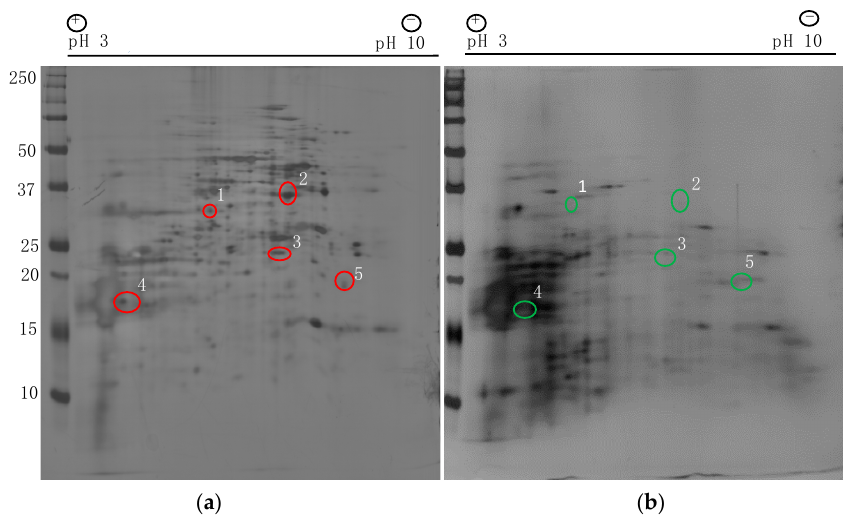
Figure 1. Cell surface proteins extracted from Candida auris biofilm and planktonic cells and resolved by 2-Dimensional Gel Electrophoresis (2-DE). Silver stained gel images of proteins from biofilm ( a ) and planktonic cells ( b ). Protein spots marked with red circles ( a ) are excised out and identified by mass spectrometry. These proteins were expressed less or were absent in planktonic cells (marked in green circles) ( b ). Table 2. List of proteins identified by MS. Proteins are selected on the basis of their peptide ion signal intensity, matching peptide and sequence coverage. Q -value of zero applies to all identified proteins. Spot no. Protein Spot C. no.